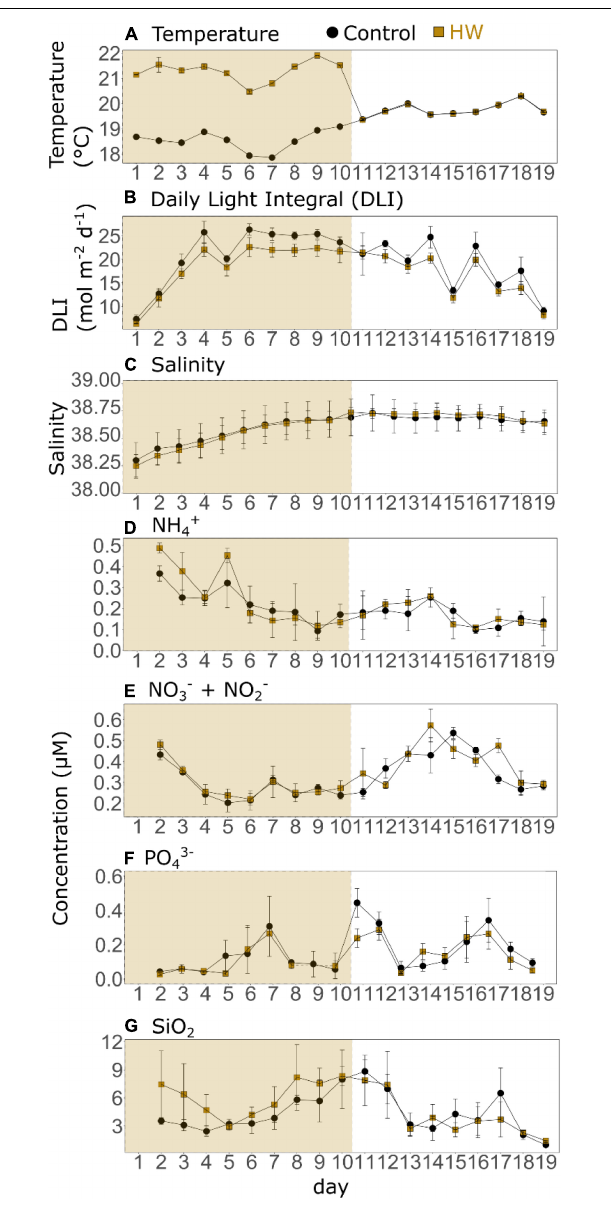
FIGURE 1 | Daily means of water temperature (A) , daily light integral (DLI, B ), and salinity (C) ; and daily concentrations of ammonium (NH 4 + , D ), nitrate + nitrite (NO 3 − +NO 2 − , E ), orthophosphate (PO 43 − , F ), and silicate (SiO 2 , G ) in the control (black) and HW (gold) treatments. The gold shaded area represents the HW period during which the +3 ◦ C was applied in the HW mesocosms. Error bars represent the standard deviation. Note that the scales of the y-axes are different. Nutrient data were lost on d1 due to a technical